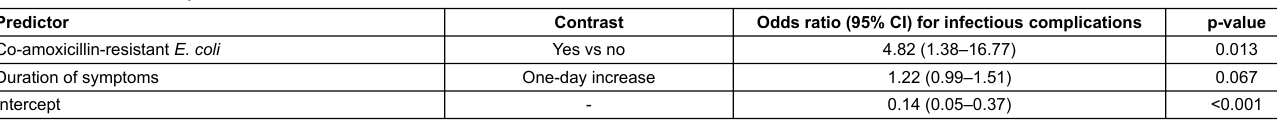
Table 3: Multivariable analysis. Predictor Contrast Odds ratio (95% CI) for infectious complications p-value Co-amoxicillin-resistant E. coli Duration of